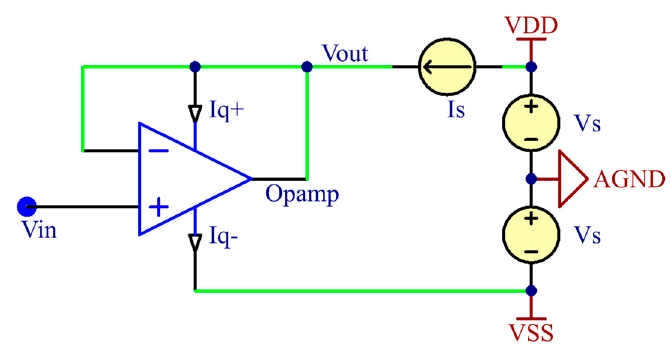
Figure 1. Simplified schematic of bipolar two-wired active electrode with bootstrapping topology.